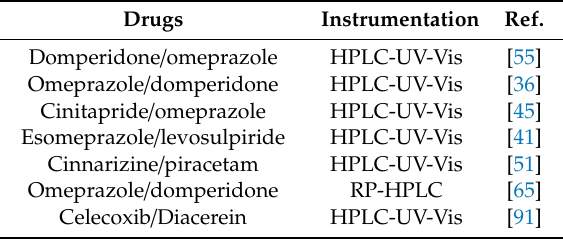
Table 2. HPLC procedures developed and validated for binary drug-association co-formulation analyses in capsules.